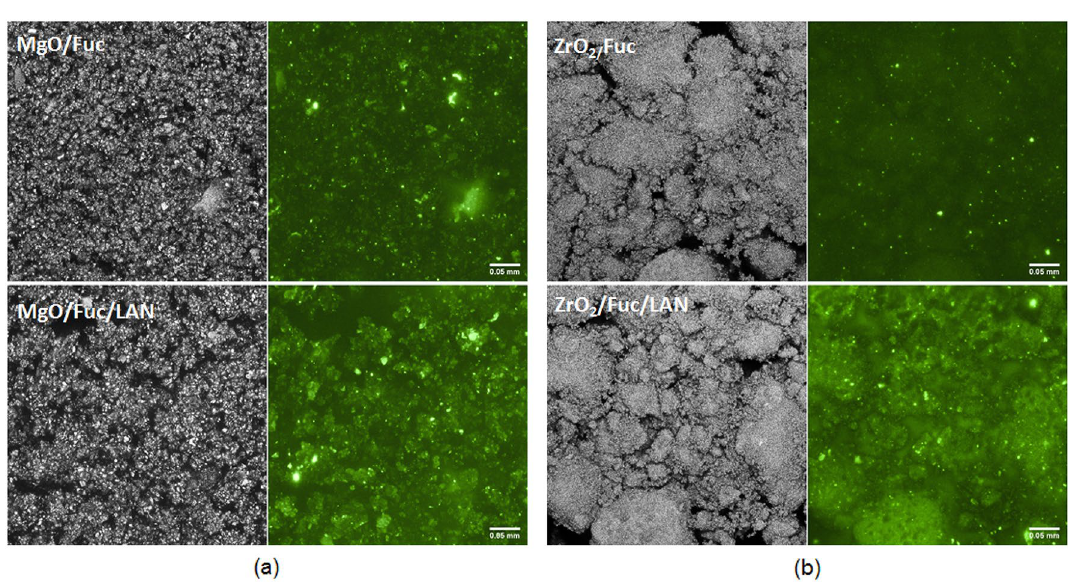
Figure 8. Confocal microscopy images of MgO/Fuc and MgO/Fuc/LAN ( a ); ZrO 2 /Fuc and ZrO 2 /Fuc/LAN ( b ) in reflection and fluorescence